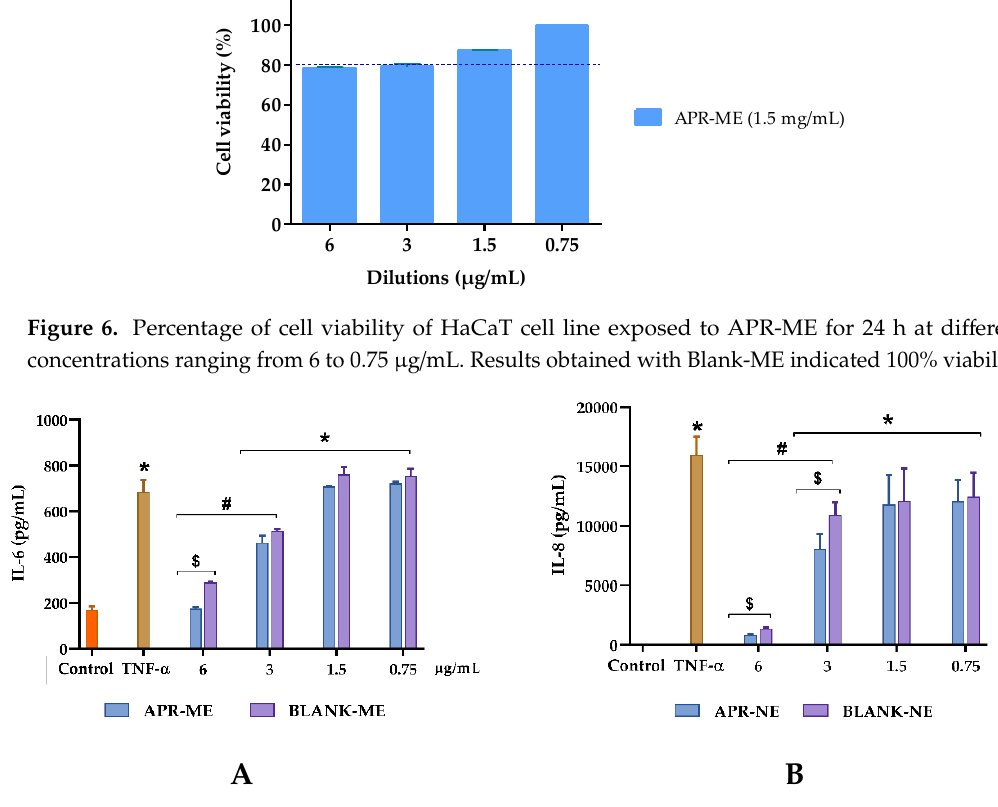
Figure 9. Ear thickness. Results are expressed as mean ± SD ( n = 3). Statistically significant differences: *, p < 0.05; **, p < 0.01; ns, not significant. 2.8.1. Biomechanical Skin Properties Evaluation After inducing inflammation, stratum corneum hydration (SCH) was not significantly affected across all study groups. However, it is necessary to highlight the evident moisturizing action of different treatments, especially to APR-ME (Figure 10). 0